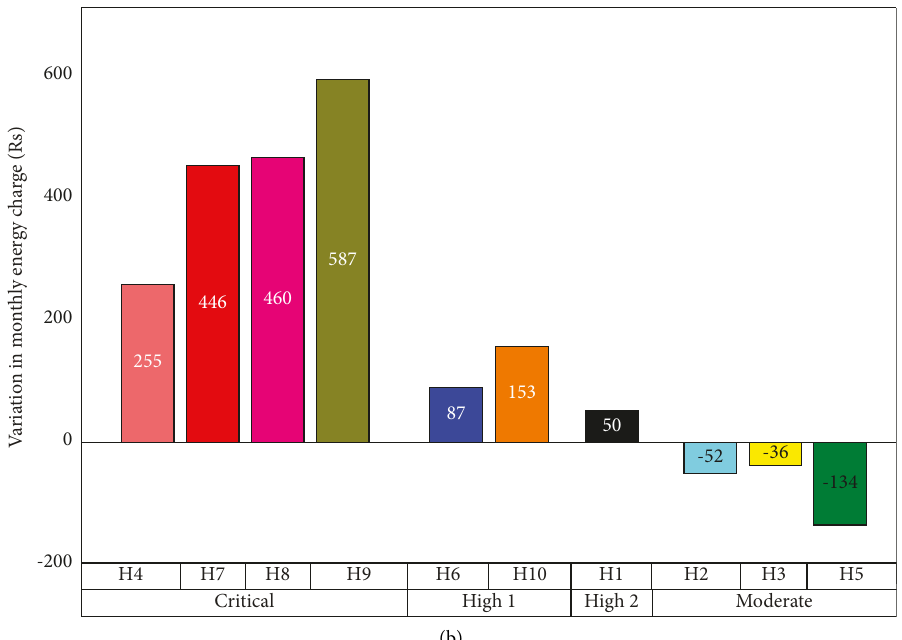
Figure 12: The difference in monthly energy charge with C-ToU compared to base tariff: (a) summer month and (b) nonsummer month.